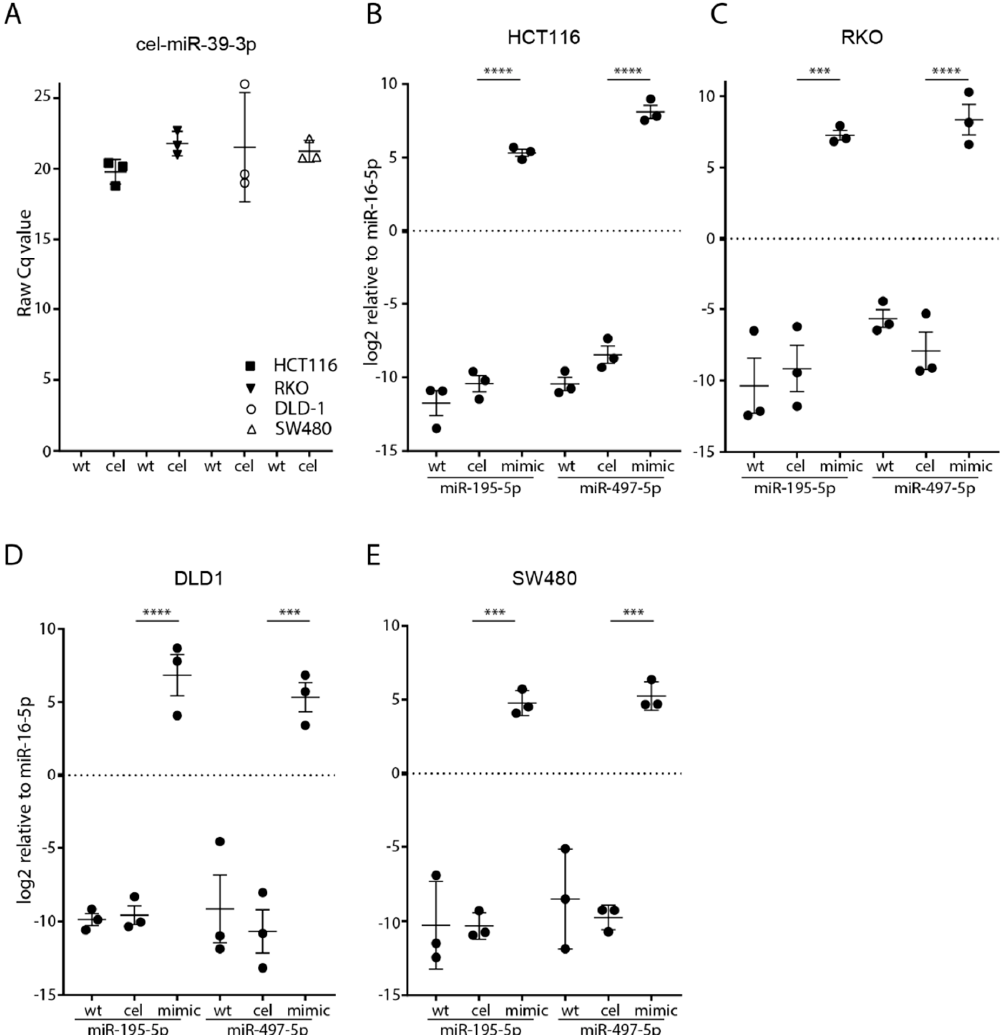
Figure 1. miRNA expression and transfection efficiency in CRC cells. Successful transfection of cel- miR-39-3p in the negative control transfected cells for all four different CRC cell lines ( A ). y -axis represents raw Cq value of cel-miR-39-3p. Successful transfection of miR-195-5p and miR-497-5p in the four different cell lines HCT116 ( B ), RKO ( C ), DLD1 ( D ) and SW480 ( E ). y -axis represents log2 expression of miR-195-5p and miR-497-5p relative to miR-16-5p (control). Data is presented as the mean of three independent transfection experiments (measured in duplicate) ± the standard error of the mean. *** p < 0.001, **** p < 0.0001, wt: wild-type, cel: cel-miR-39-3p negative control transfection, mimic: expression level 48 h after transfection.